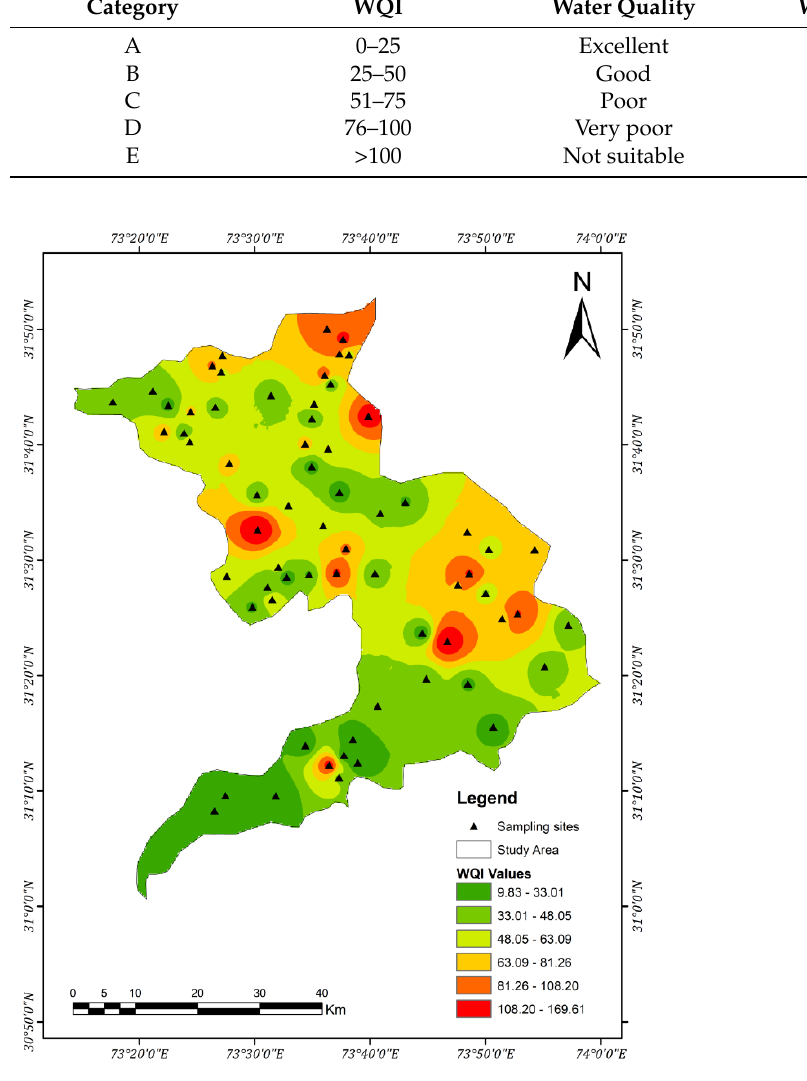
Figure 12. Spatial distribution map of WQI.